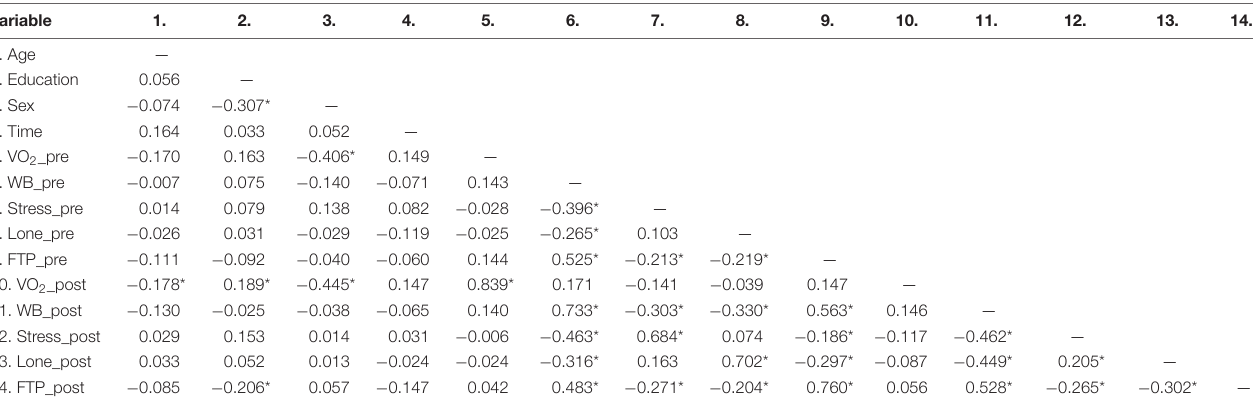
TABLE 2 | Intercorrelations of study measures before and after the intervention across all groups.